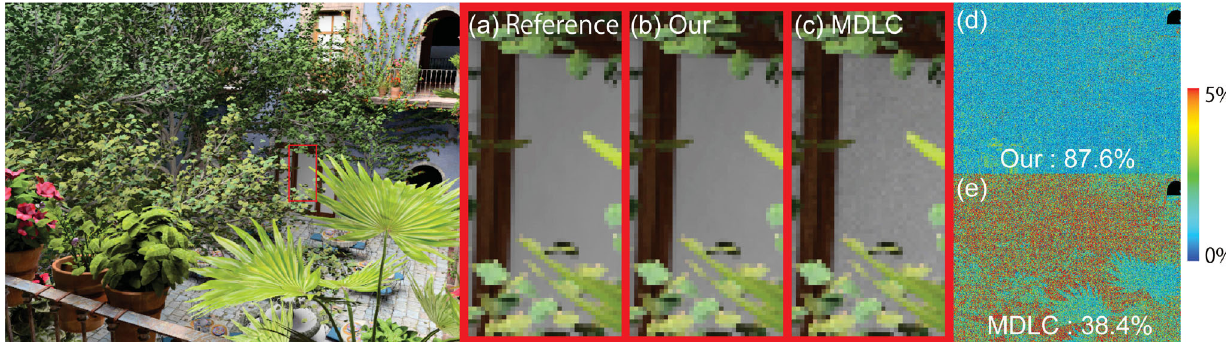
Fig. 1 Rendering with anti-aliasing (256 spp): (a) reference, (b) our method, (c) multidimensional lightcuts (MDLC). (b) and (c) are rendered so that the relative errors are less than 2%. (d) and (e) indicate relative errors (error color-code shown at far right). Values in (d) and (e) give the percentages of pixels with relative errors of less than 2%. Our method improves the estimation accuracy of pixel values by approximately 50% compared to MDLC. The low estimation accuracy of MDLC results in noise as shown in